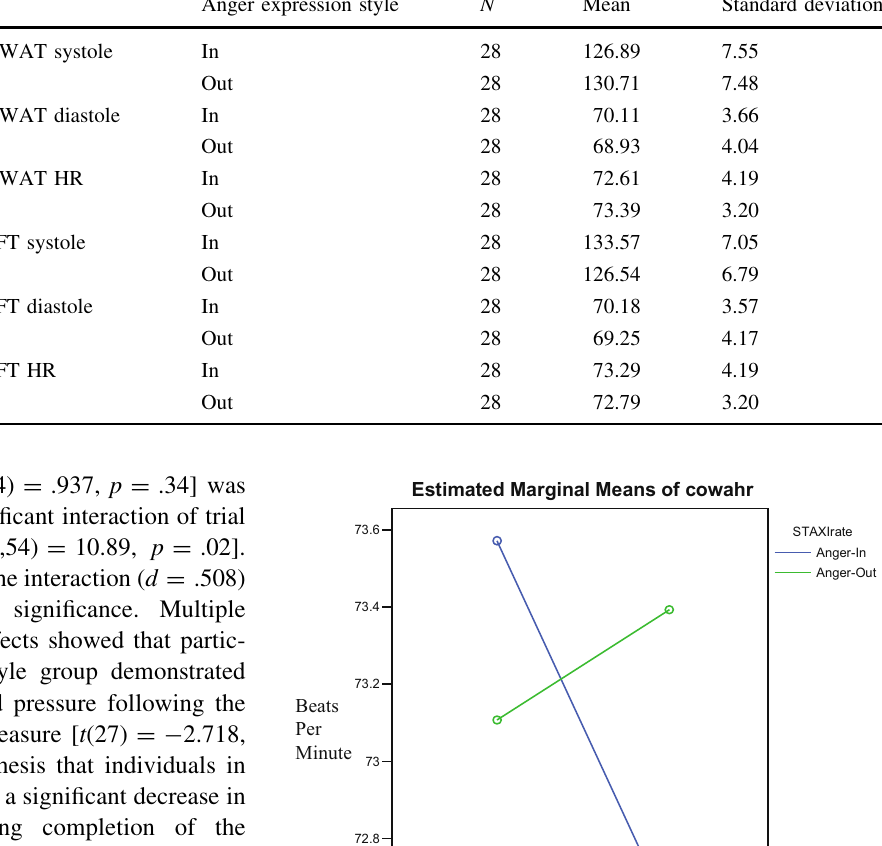
Table 2 Means and SD for post-fluency systole, diastole, and heart rate